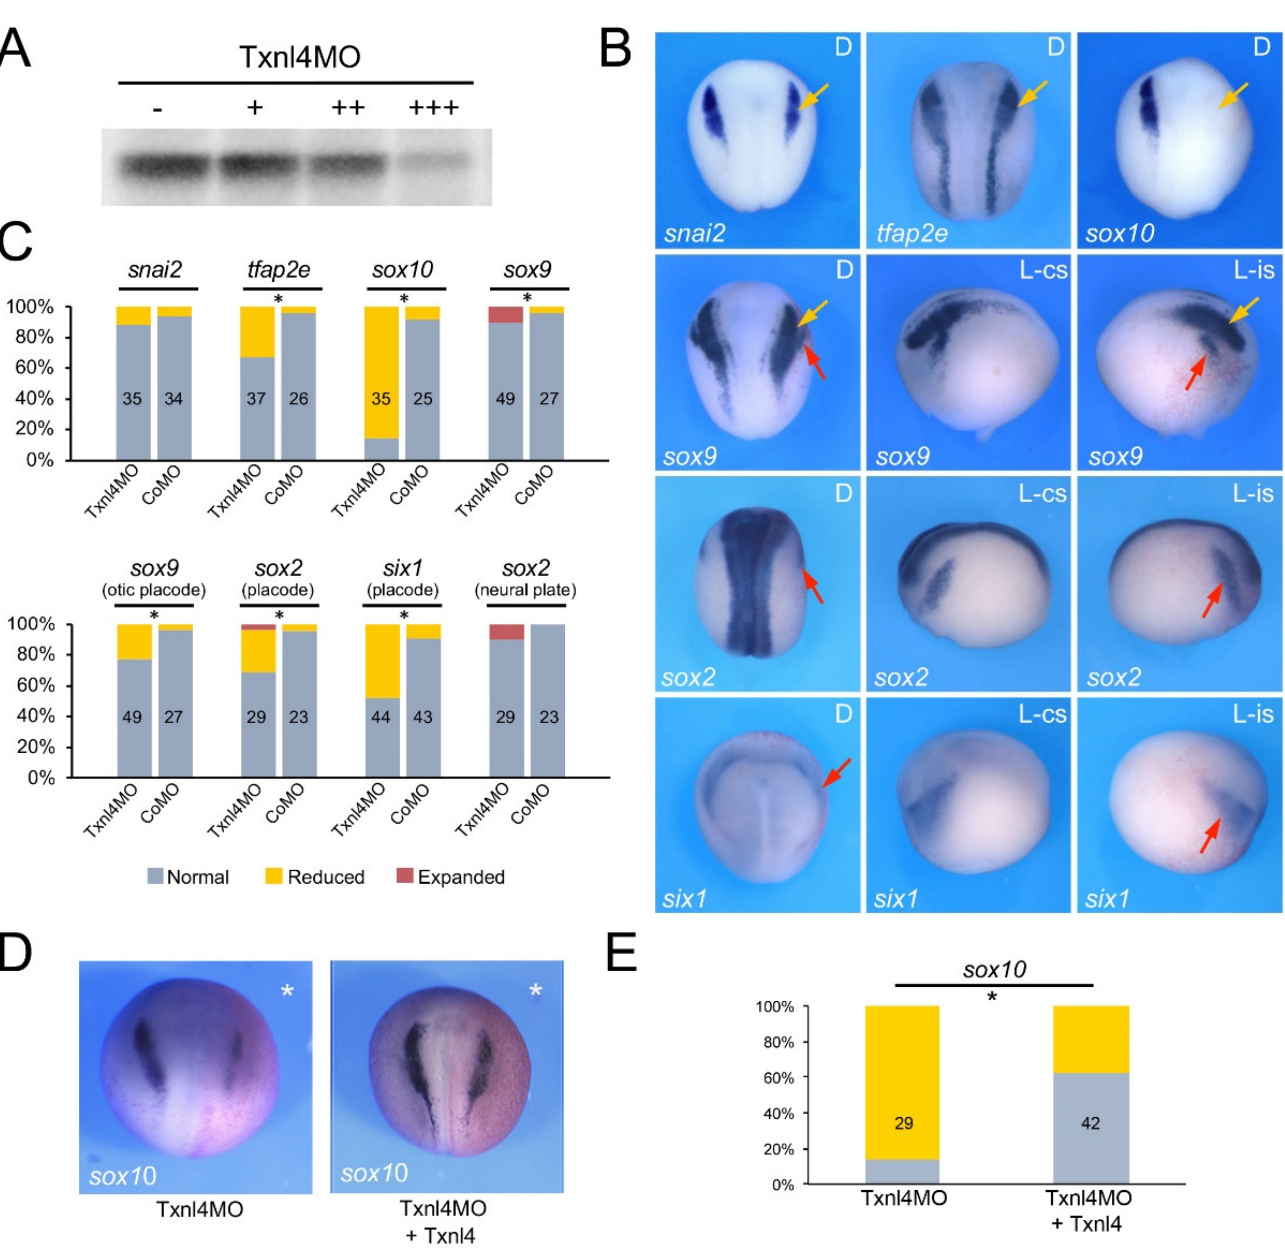
Figure 4. Txnl4a knockdown affects neural crest formation. ( A ) Increasing amounts of Txnl4MO, 10 ng (+), 100 ng (++) and 500 ng (+++), block translation directed by txnl4a mRNA. (-) Translation without Txnl4MO. ( B ) Phenotype of Txnl4MO-injected embryos (30 ng) on neural crest (yellow arrows) and placode (red arrows) gene expression at stage 15. The gene analyzed in each panel is indicated in the lower left corner. D indicates dorsal view, anterior to top. L-cs indicates lateral view control side, anterior to left. L-is indicates lateral view injected side, anterior to right. ( C ) Quantification of the phenotypes. The numbers in each bar indicate the number of embryos analyzed. ( D ) sox10 expression in Txnl4MO-injected embryos is partially restored by expression of Xenopus Txnl4 resistant to the MO. The injected side is indicated by an asterisk. Dorsal views, anterior to top. ( E ) Quantification of the results. The numbers in each bar indicate the number of embryos analyzed. Statistically significant differences are indicated (*) p -value < 0.05 (Chi-squared test).